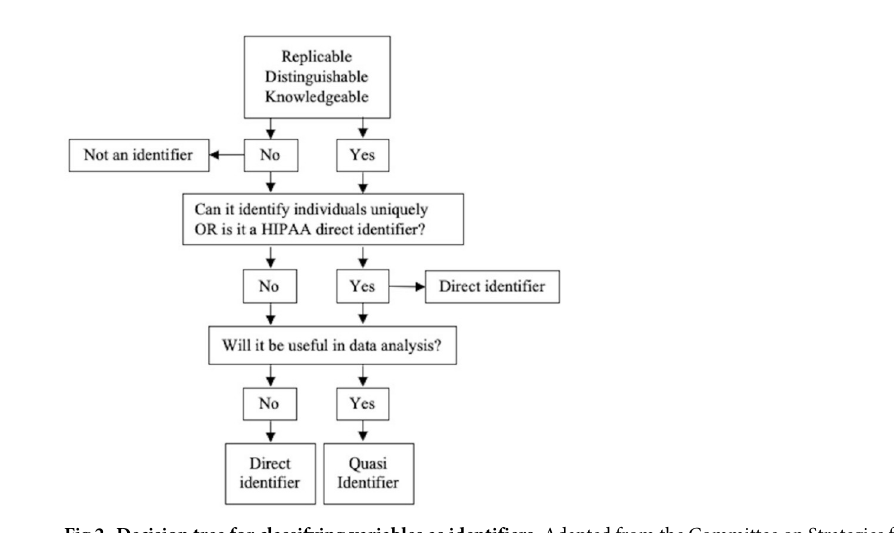
Fig 2. Decision tree for classifying variables as identifiers. Adapted from the Committee on Strategies for Responsible Sharing of Clinical Trial Data [20].